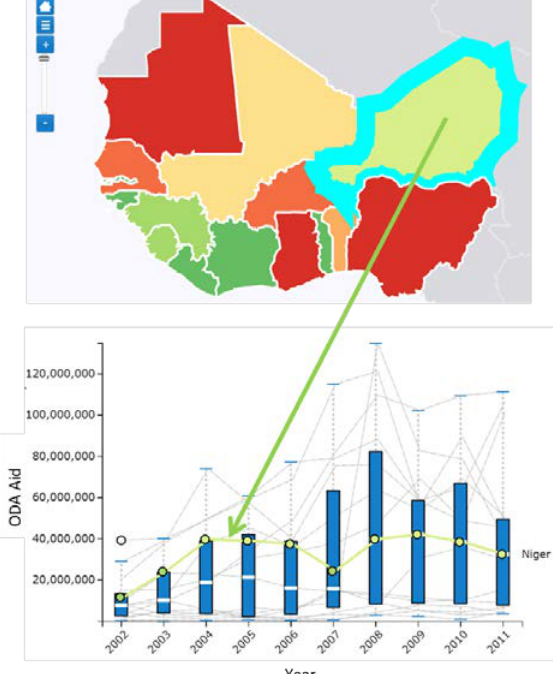
Figure 7. Box plots showcasing map link